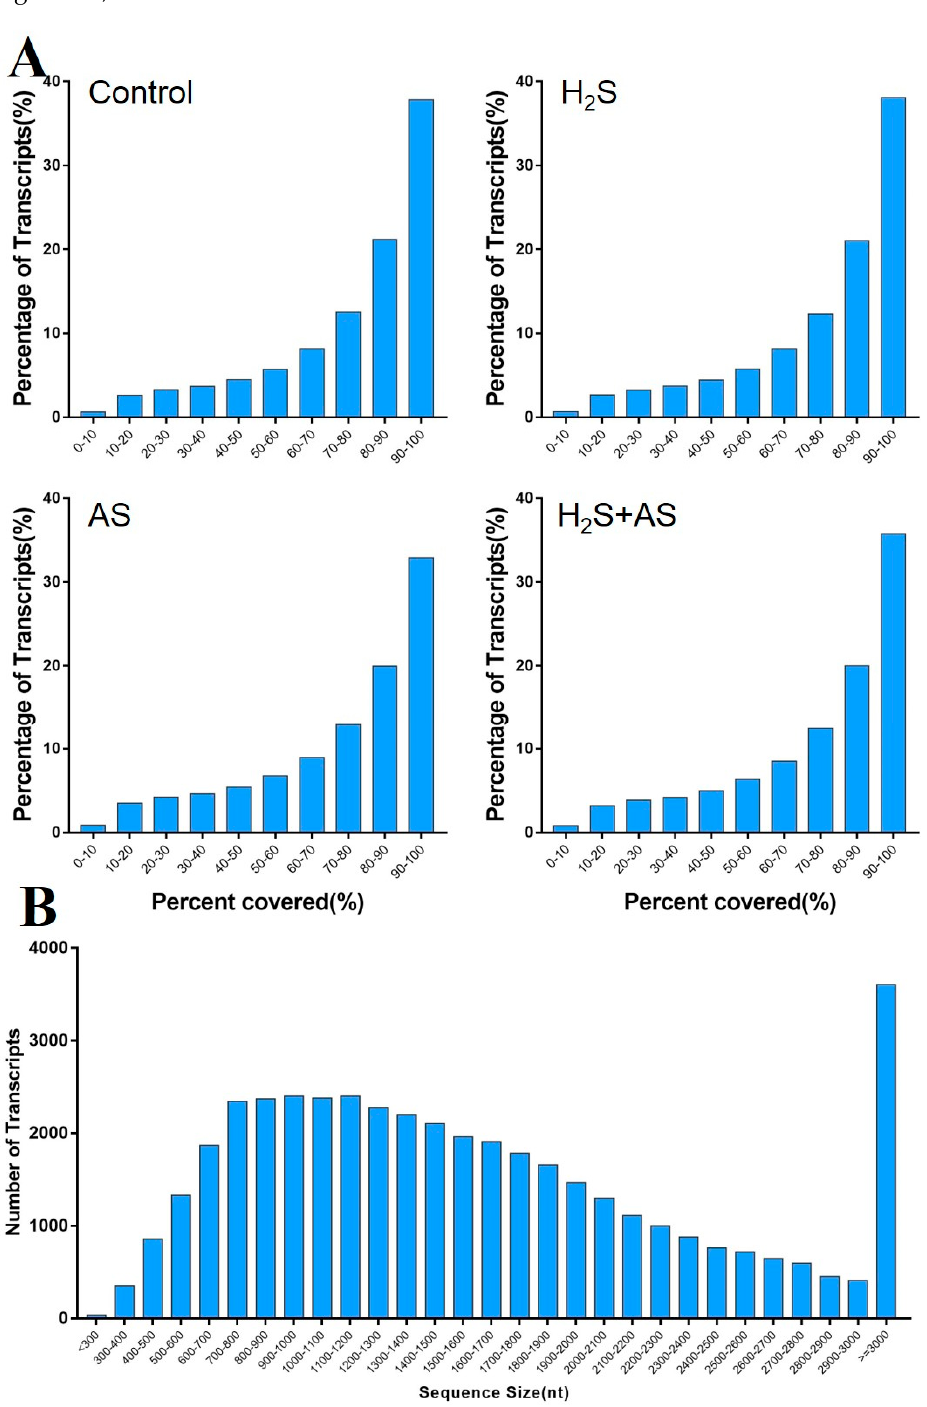
Figure 1. ( A ) Reads’ coverage of transcripts and ( B ) length distribution of known gene transcripts treated with H 2 S and alkaline salt stress.